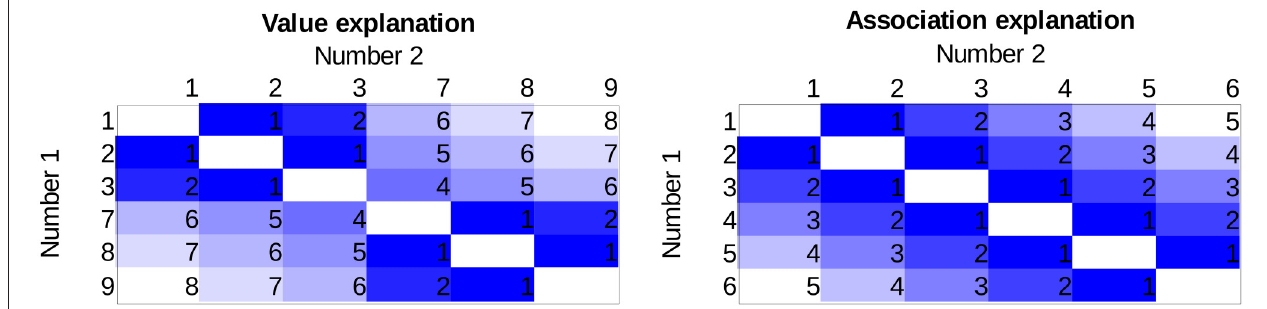
FIGURE 2 | The expected distance effect pattern for the stimulus space used in the present study based on the value explanation (left side) and based on the association explanation (right side) . Specific values in the cells are the difference of the values (value model) or the difference of the order (association model) of the numbers to be compared on an arbitrary scale. Darker color indicates worse performance.